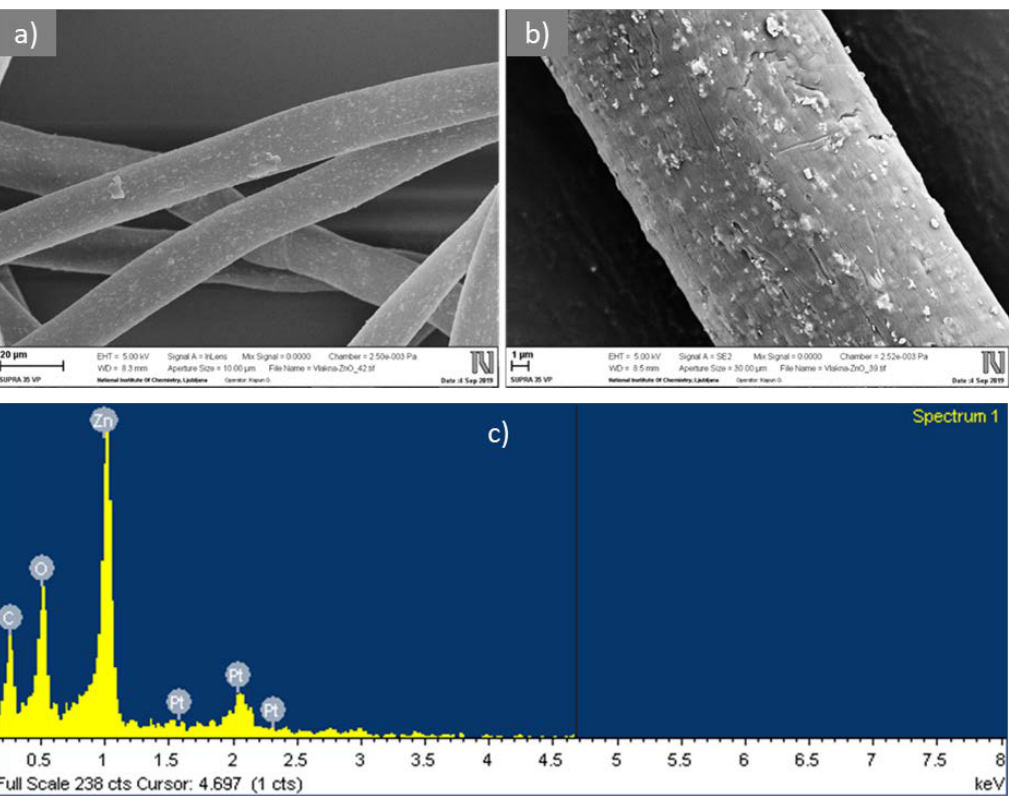
Figure 1. Scanning electron microscopy / Backscattered-Electron images (SEM / BSE) of CLY fibers at lower ( a ) and higher ( b ) magnification and energy-dispersive X-ray spectrometer (EDS) spectrum acquired from ZnO particles ( c ).